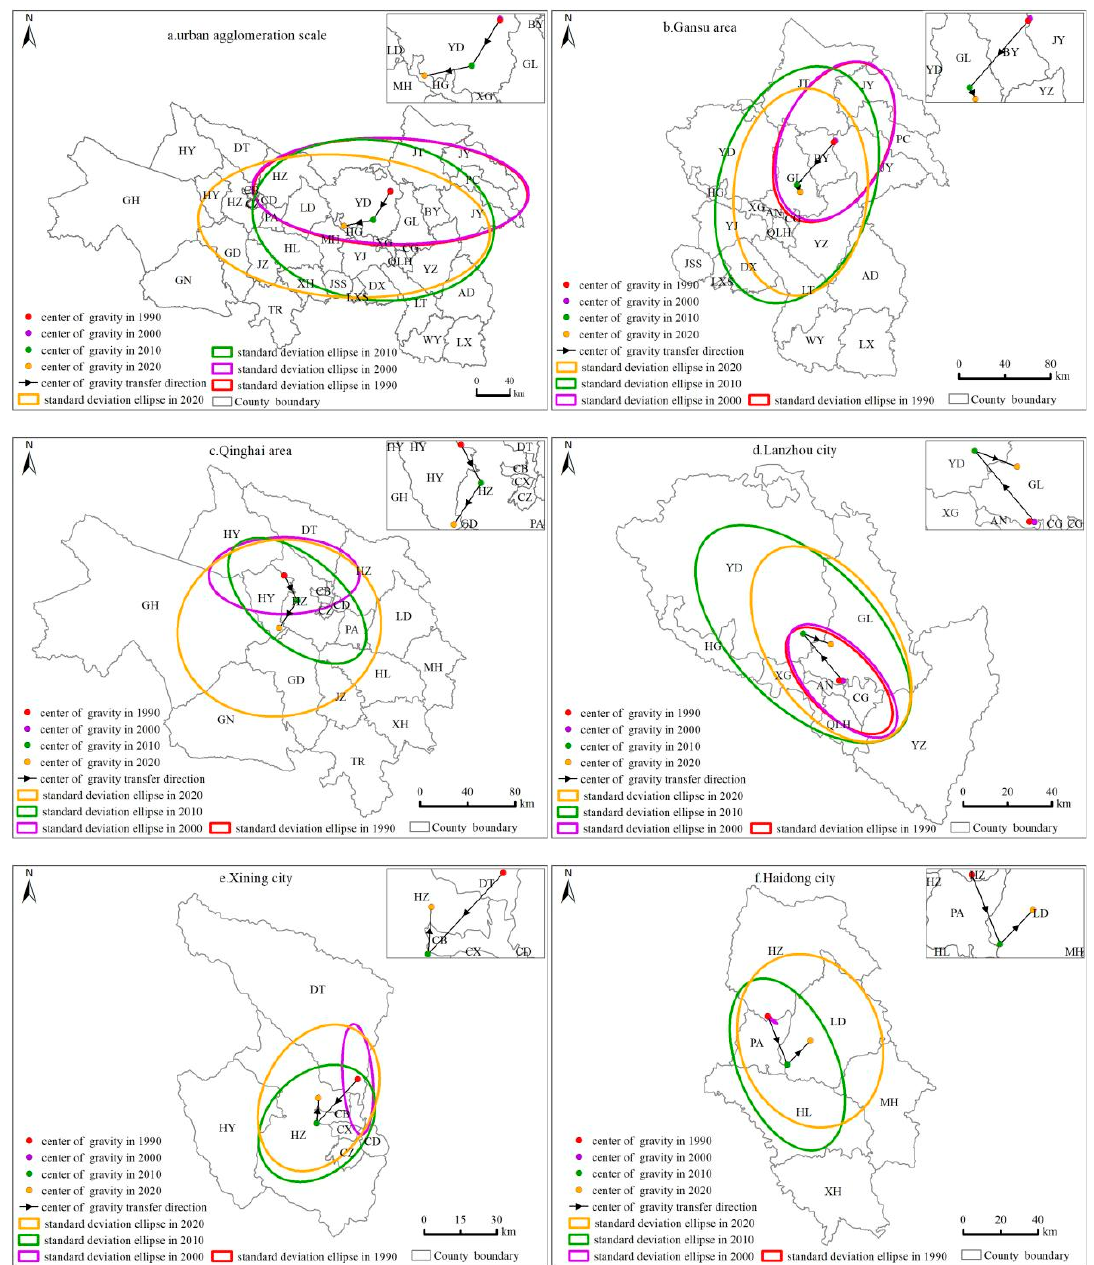
Figure 8. Distributions of central other construction land shifts at the city level in the study area from 1990 to 2020.